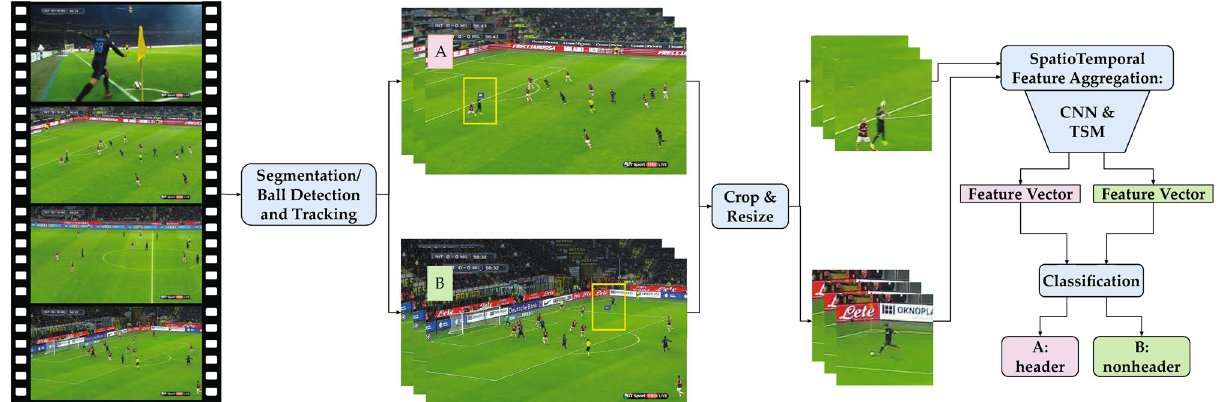
Figure 1. Overview of the proposed header detection algorithm. The video is divided into short segments and ball position is detected and tracked in each segment. Each frame is then cropped around the ball position. Spatiotemporal features of each cropped video segment are extracted using a convolutional neural network (CNN) and temporal shift module (TSM). The extracted feature vector is then classified as a header or nonheader event in the last step of the